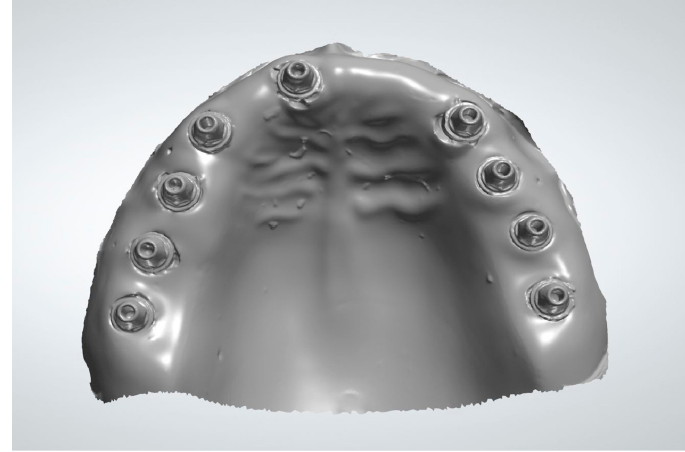
Figure 5. Scan image of the stone cast.